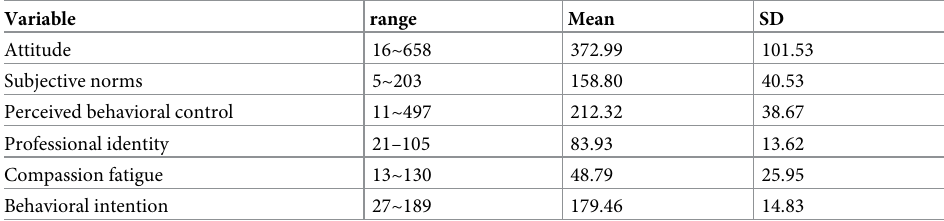
Table 2. The attitude, subjective norm, perceived behavioral control, professional identity, compassion fatigue and behavioral intention of nurse to care for COVID-19 patients on mechanical ventilation.